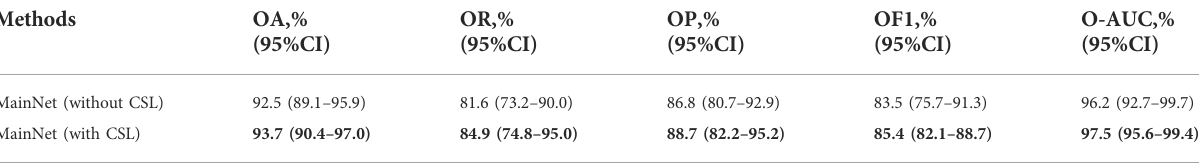
TABLE 3 Statistical comparison of MainNet with different class imbalance processing methods. Methods